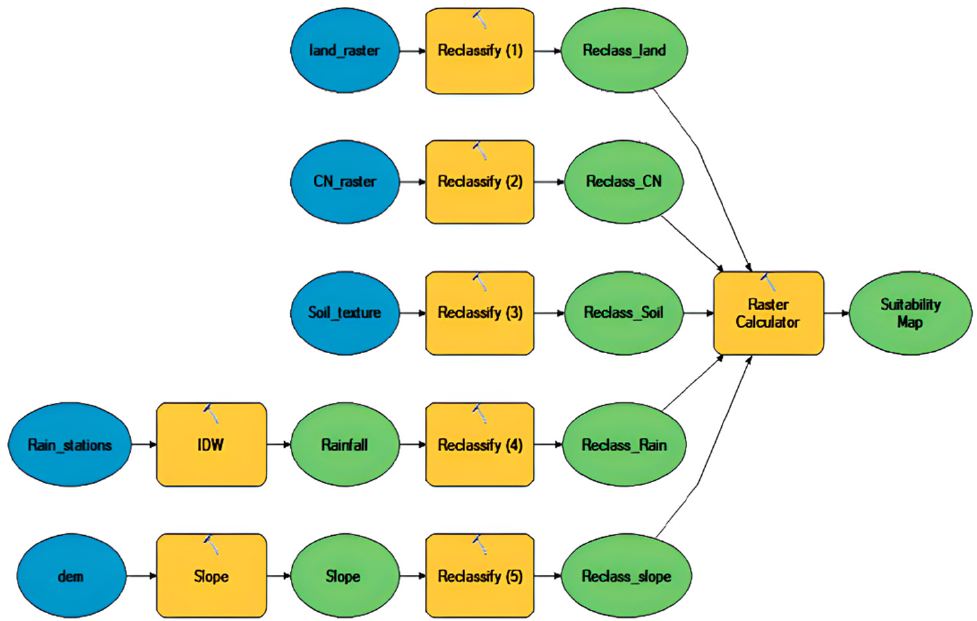
Figure 2. Flow chart for the identification of RWHt suitability map.